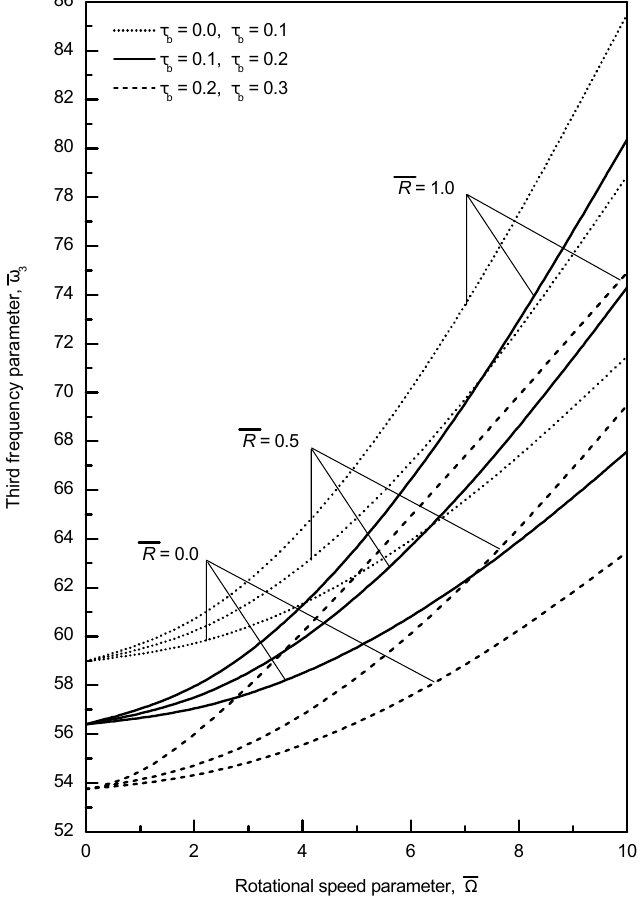
Fig. 5. Effect of unequal tapering on the third frequency parameter of rotating Euler-Bernoulli beam. 1 k c = 2 , 1